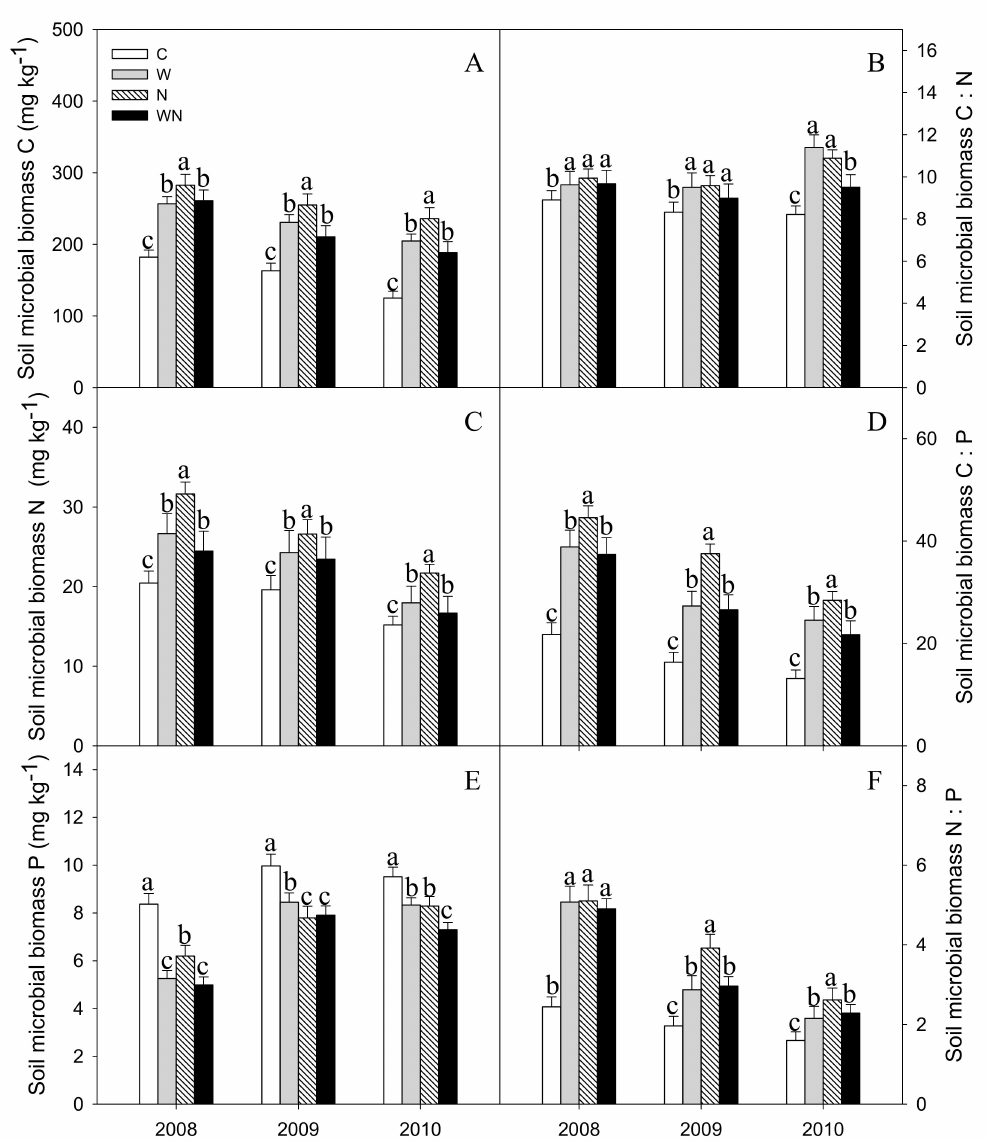
Figure 4. Responses of soil microbial biomass C ( A ), N ( C ), P( E ) contents and C:N ( B ), C:P ( D ), N:P ( F ) stoichiometry to warming and N addition. Vertical bars represent the standard error of the mean (n = 6). Di ff erent lowercase letters indicate significant di ff erences ( P < 0.05). See Figure 2 for